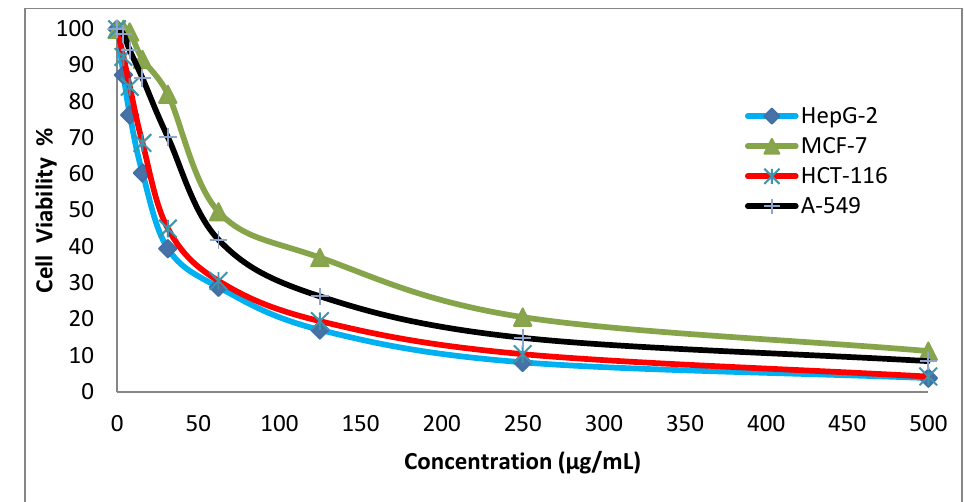
Figure 2. Evaluation of the cytotoxic effects of disperse dye 1. HepG-2: Hepatocellular carcinoma cells, MCF-7: breast cancer cells; HCT-116: colon carcinoma cells; A-549: Lung carcinoma cells.